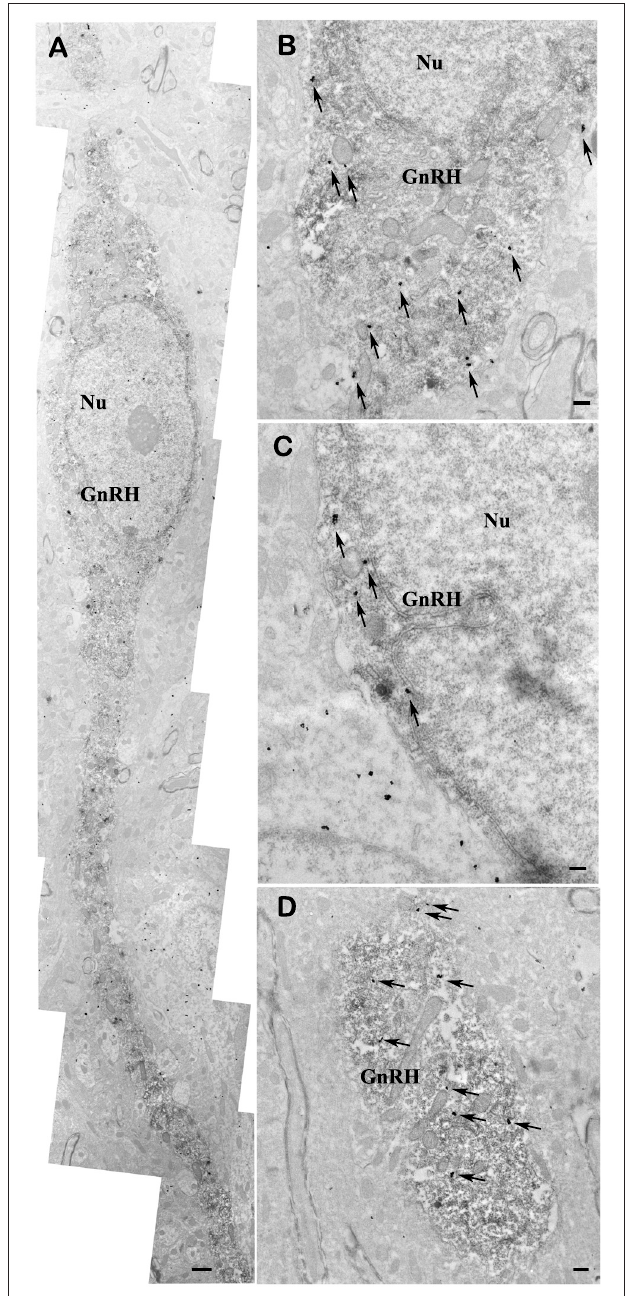
FIGURE 6 | Co-localization of nNOS and GnRH in the preoptic area of mice. Electron micrographs showing strong nNOS immunogold labeling in GnRH neurons (A–D) . The nNOS-immunoreactivity (nNOS-IR) is detected with highly electron dense gold–silver particles (arrows), while the presence of the electron dense DAB chromogen identifies the GnRH-IR structures. nNOS-IR characterizes both perikarya (A–C) and dendrites (A,D) of GnRH neurons. Low-power micrograph (A) illustrates the overall presence of nNOS-IR in the perikaryon and processes of a fusiform GnRH neuron. High-power micrographs (B–D) depict the localization of nNOS-IR in the perinuclear cytoplasm (B,C) and the dendritic domain (D) of immunolabeled GnRH neurons. Note the expression of nNOS in a neuron located left to the double-labeled GnRH cell (C) . Scale bar = 1 µ m in (A) and 0.4 µ m in (B–D) , Nu, nucleus; GnRH, gonadotropin-releasing hormone